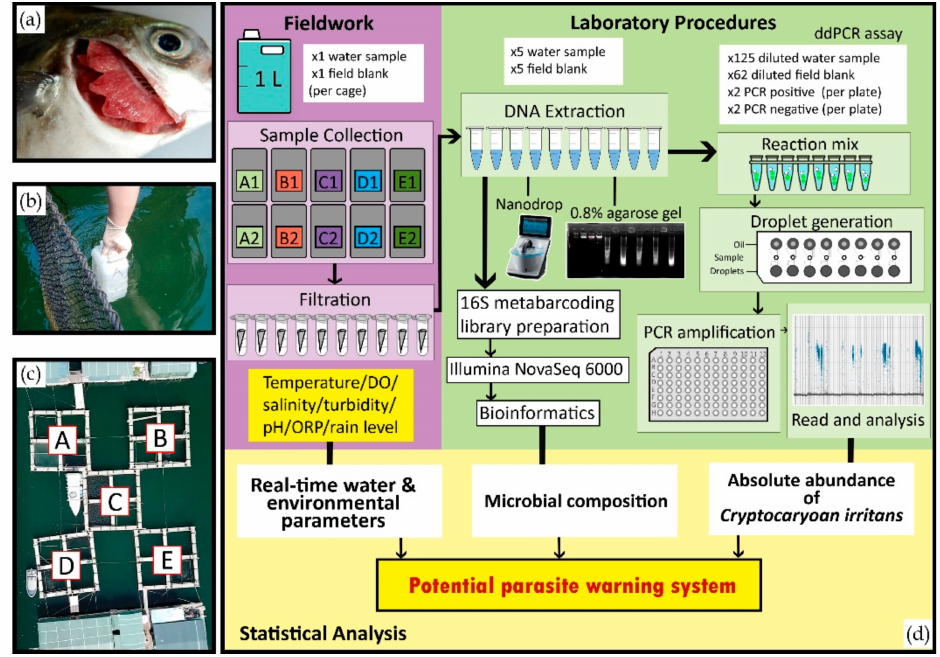
Figure 1. Field sampling from a marine net-pen fish farm in Hong Kong and the systematic work- flow: ( a ) Gills from juvenile pompano ( Trachinotus blochii ) infected by Cryptocaryon irritans used for confirmation of infection caused by this parasite; ( b ) collection of water approximately 50 cm below the water surface; ( c ) drone overview of the sampling net-pens A–E; and ( d ) graphical illustration of the key experimental procedures. DO, ORP, PCR, and ddPCR are abbreviations of dissolved oxygen, oxidizing or reducing potential, polymerase chain reaction and droplet digital polymerase chain reaction